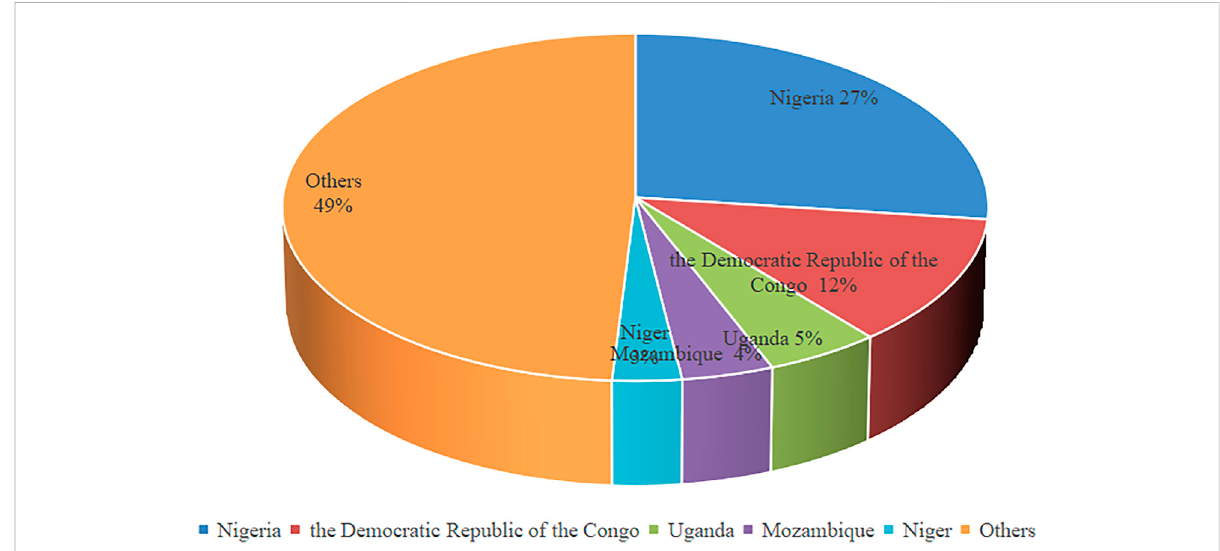
FIGURE 1 The ratio of people infected with malaria in different countries in